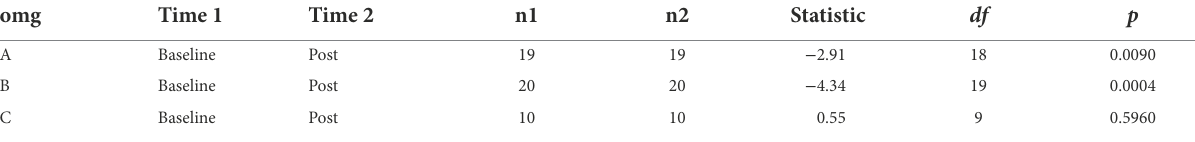
TABLE 5 Pairwise comparisons between time points (within each